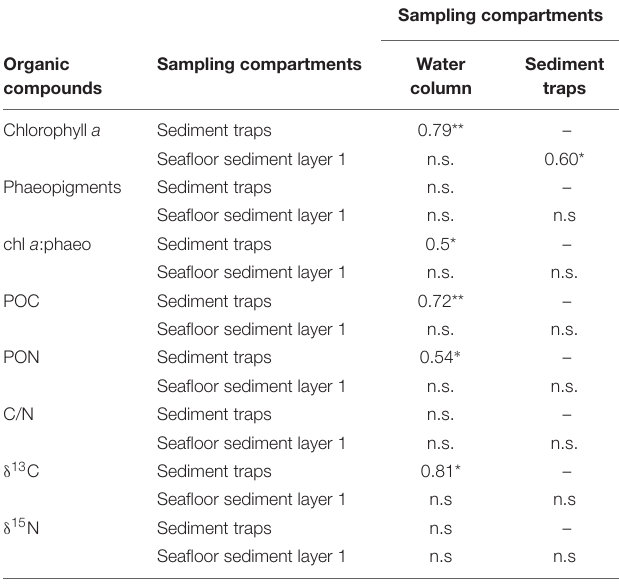
TABLE 2 | Correlations (R) between the same organic compounds across the three sampling compartments (i.e., water column, sediment traps, and seafloor sediment surface) from February to November 2016 (see Table 1